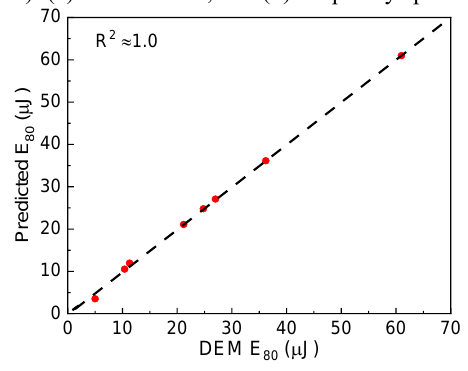
Fig. 5 Comparisons of predicted E 80 from Eq. 6 and the simulated E 80